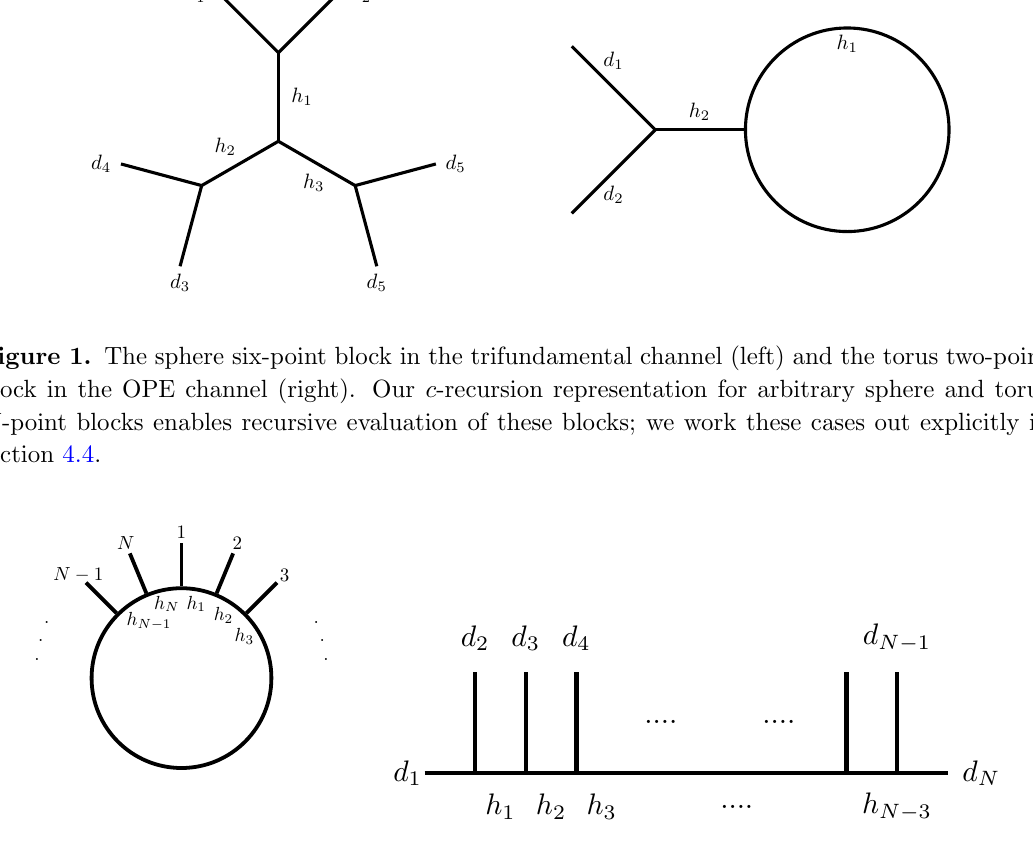
Figure 2. The torus N -point block in the necklace channel (left) and the sphere N -point block in the linear channel